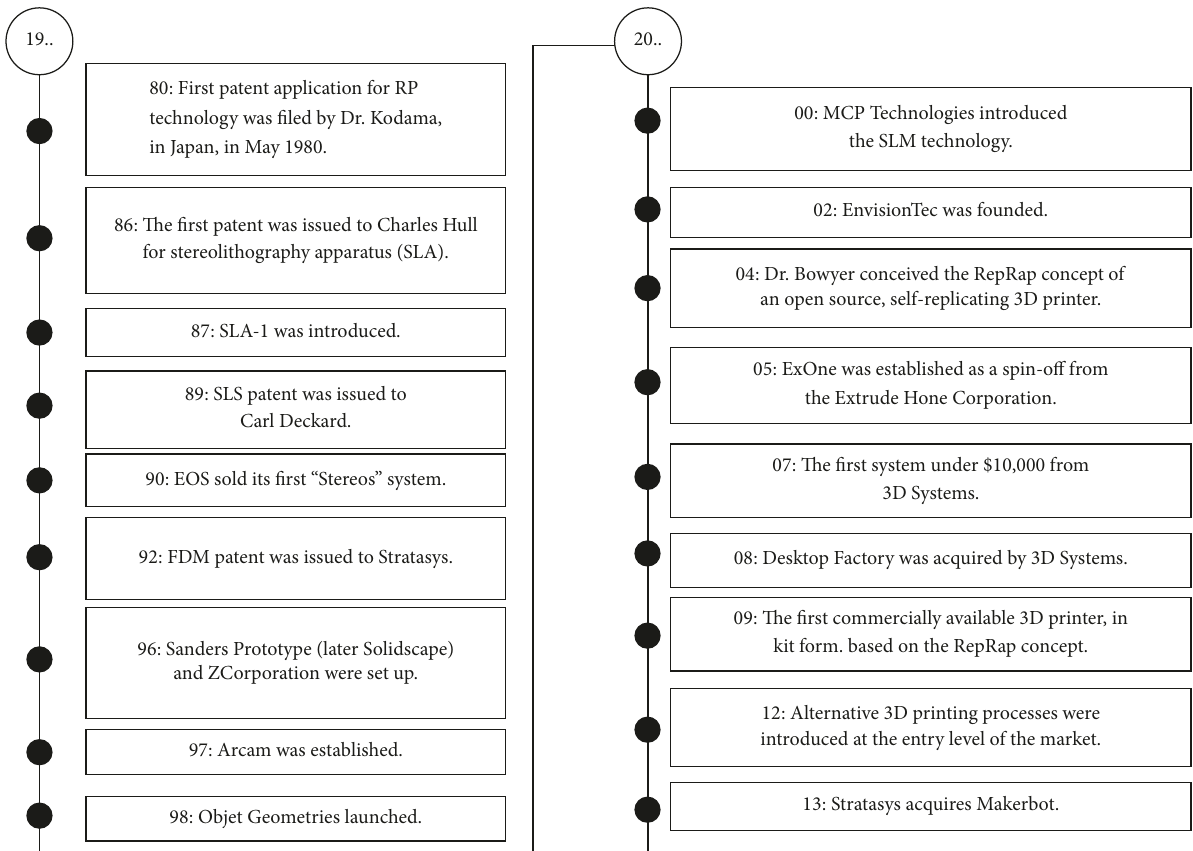
Figure 1: Chronicle of the 3D printing